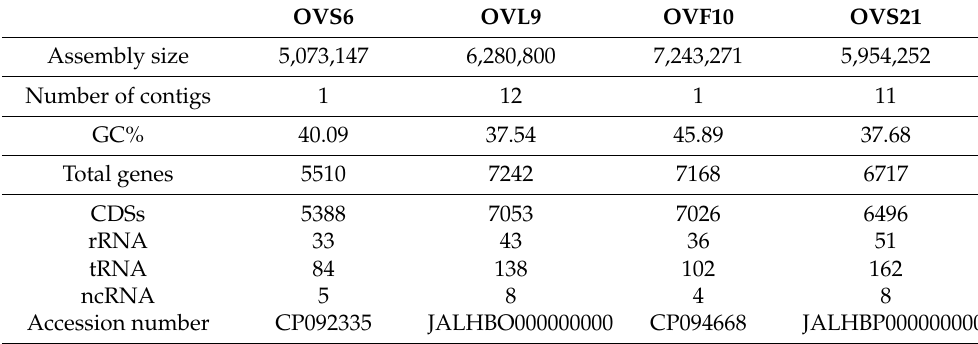
Table 1. General features of the genomes of the four endophytic strains.